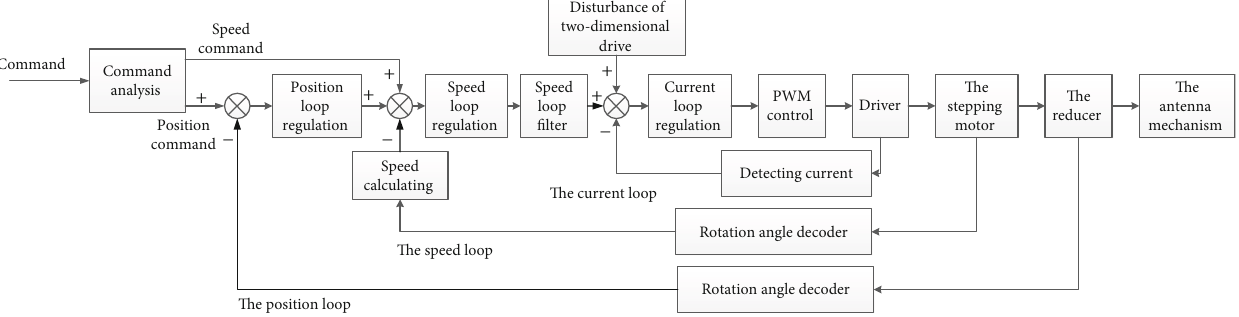
Figure 1: Block diagram of the motion